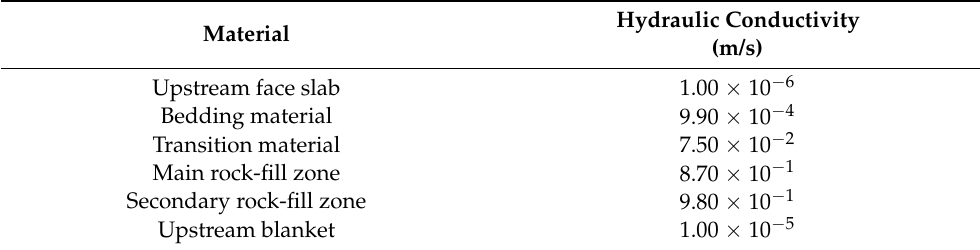
Table 3. Hydraulic conductivity of stationary